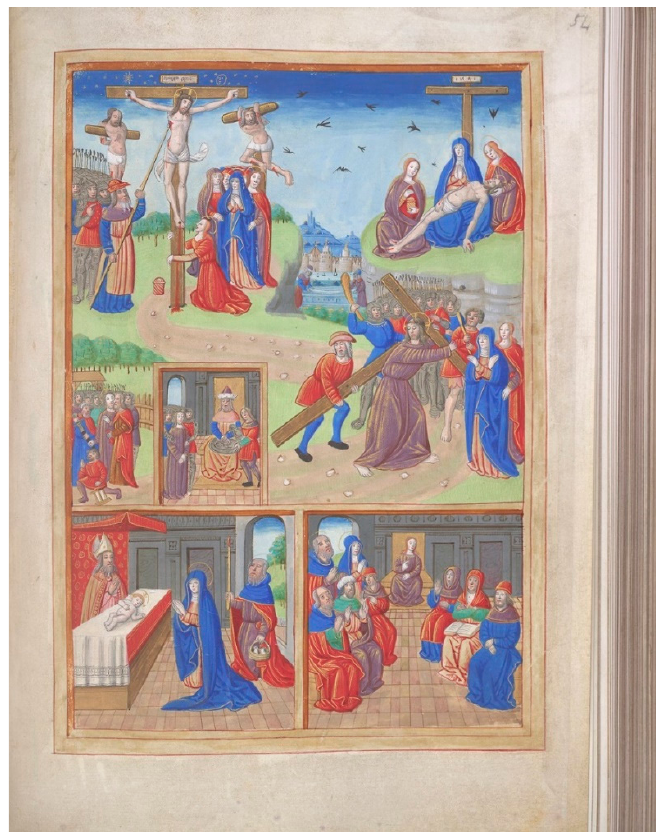
Figure 7. Pictorial cycle f.54r of the Hours of Thomas Butler, © British Library Board.